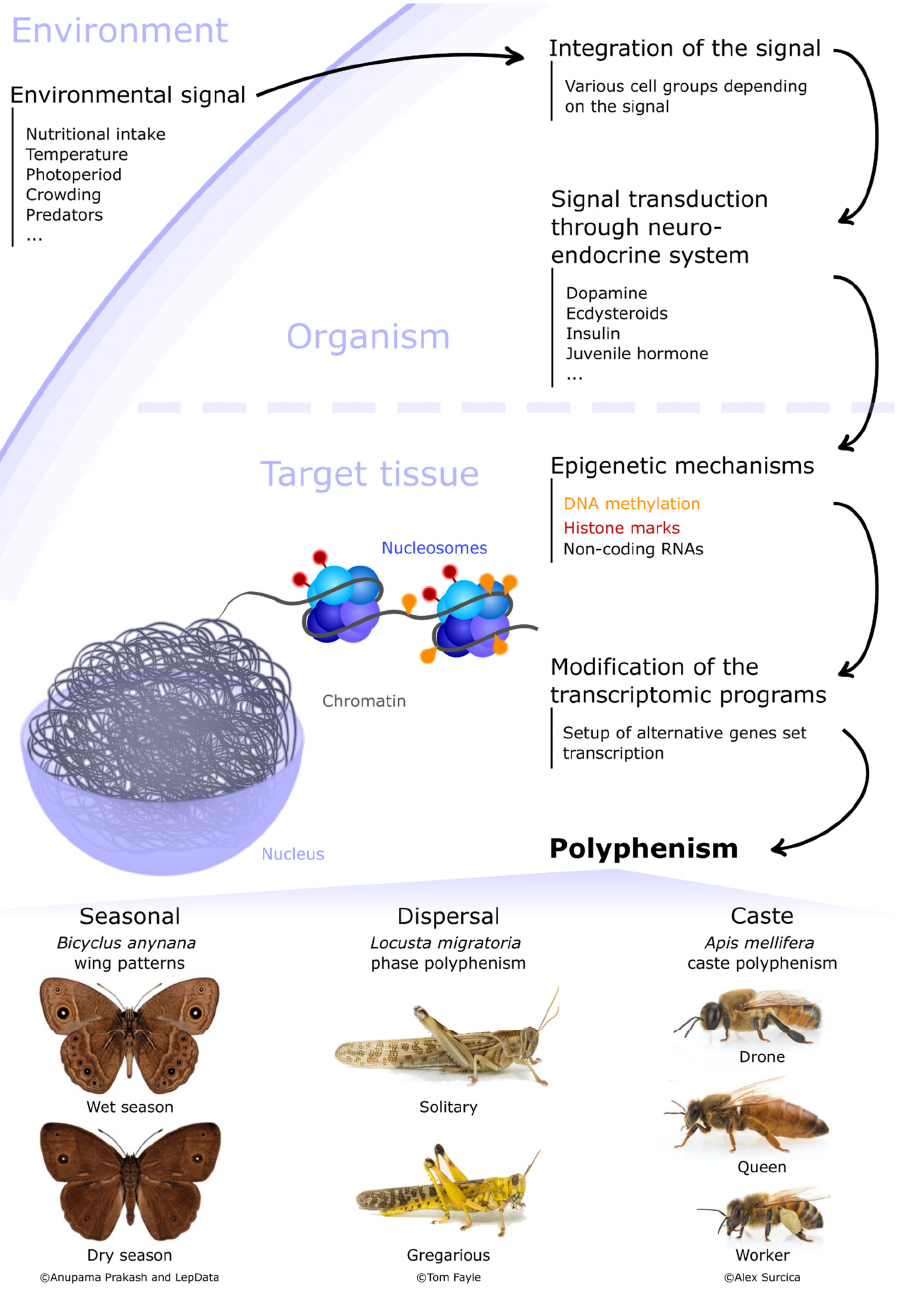
Figure 1. Insect polyphenism regulation framework. Environmental signal(s) are first perceived and integrated by specific groups of cells. This signal is then transduced to the target tissues/cells by the neuro-endocrine system, often relying on multiple hormones and neuropeptides. Epigenetic mechanisms mainly involving chromatin regulation and DNA methylation are then activated in specific cells of the target tissue(s). These mechanisms then modulate gene expression, ending up with the setup of alternative transcriptional programs underlying the production of discrete phenotypes. Examples of discrete phenotypes for three types of polyphenism are illustrated here: (i) the seasonal polyphenism of Bicyclus anynana with wet ( top ) and dry ( bottom ) season morphs (credits: Anupama Prakash, University of Singapore and LepData, 2018); (ii) the phase polyphenism of Locusta migratoria, with a solitary ( top ) and a gregarious ( bottom ) male (credits: Tom Fayle, University of Cambridge); (iii) the caste polyphenism of Apis mellifera with drone ( top ), queen ( middle ) and worker ( bottom ) morphs (credits: Alex Surcica, Digital Museum of Natural